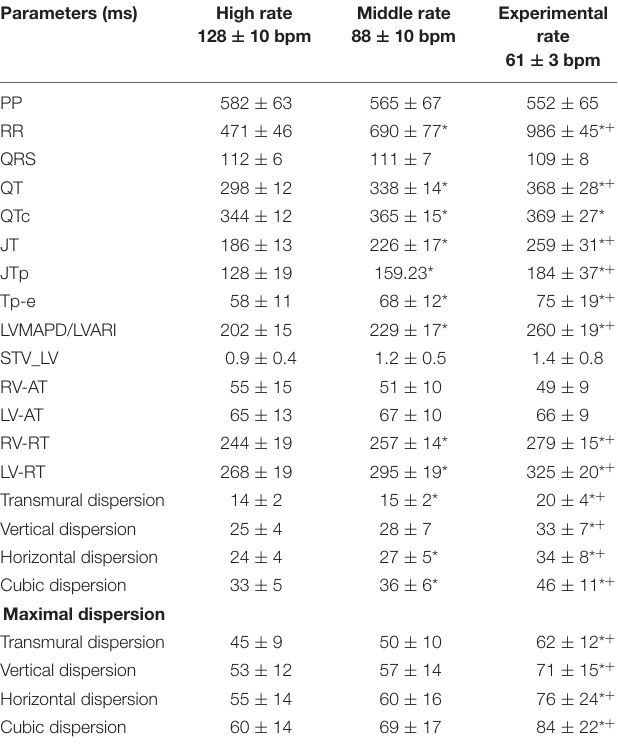
TABLE 2 | Serial comparison of the electrophysiological effects of high, middle, and experimental rate pacing ( n = 10). Parameters